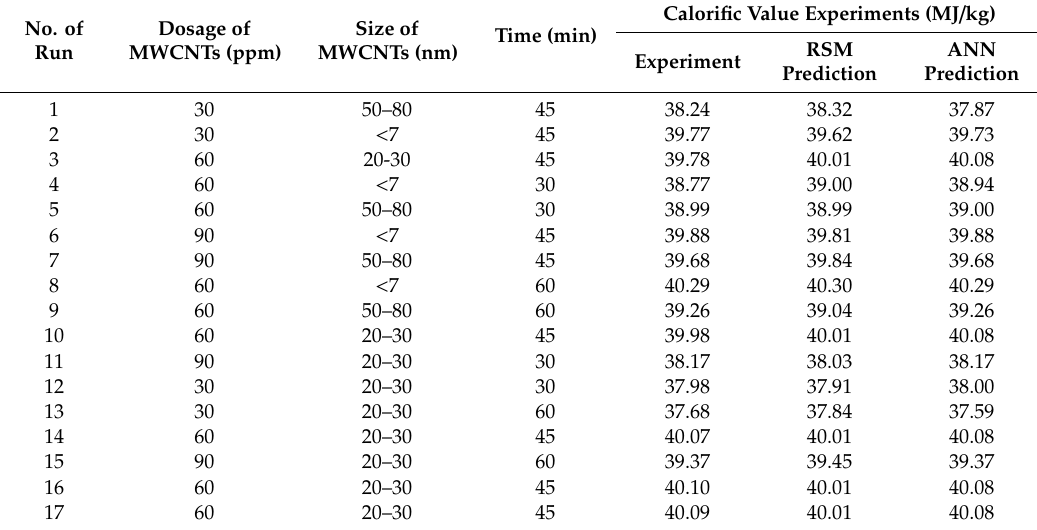
Table 2. Experimental design for optimization of the process parameters for the blending ricebran methyl ester (RBME) with multi-walled carbon nanotubes